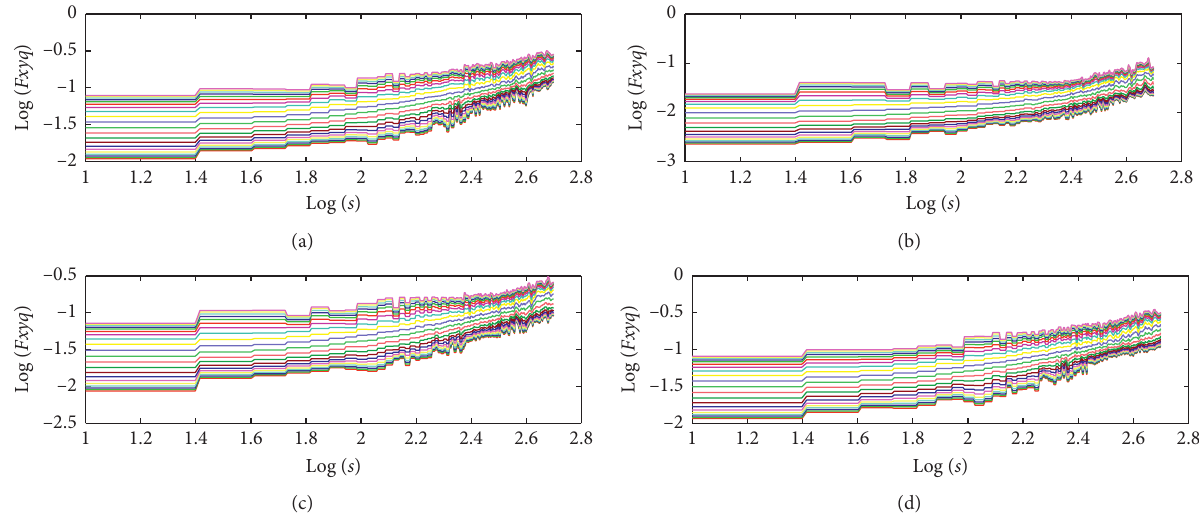
Figure 5: Log-log plots of cross-correlation fluctuation function versus time scale s for market participation willingness and Chinese stock market returns. (a) SME. (b) SSE50. (c) CSI300. (d)